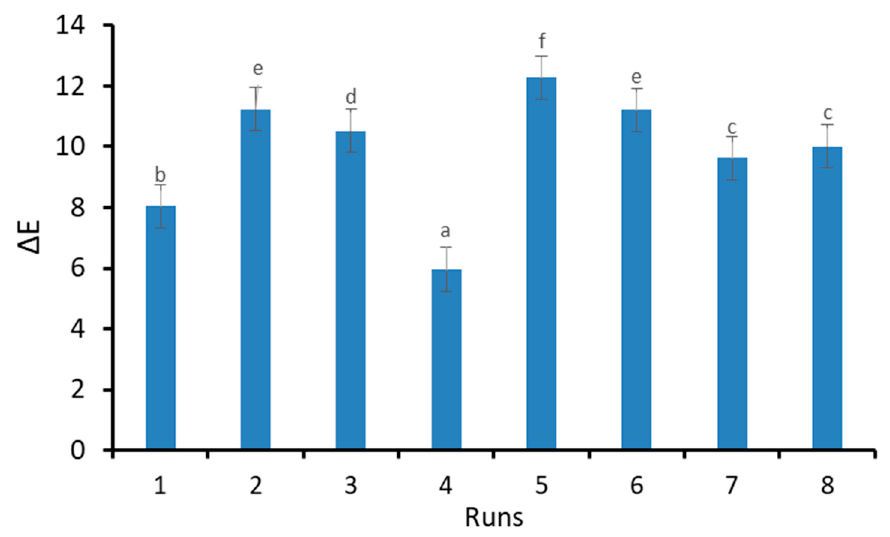
Figure 6. ∆ E between unconcentrated and concentrated milk.3.2. Modeling of milk physico-chemical properties. The deferent letters (a,b,c,d,e,f) refer to significant differences ( p < 0.05) between treatments. Table 1. Chroma, hue angle, whiteness index, yellowing index, and browning index of unconcen- trated and concentrated milk.